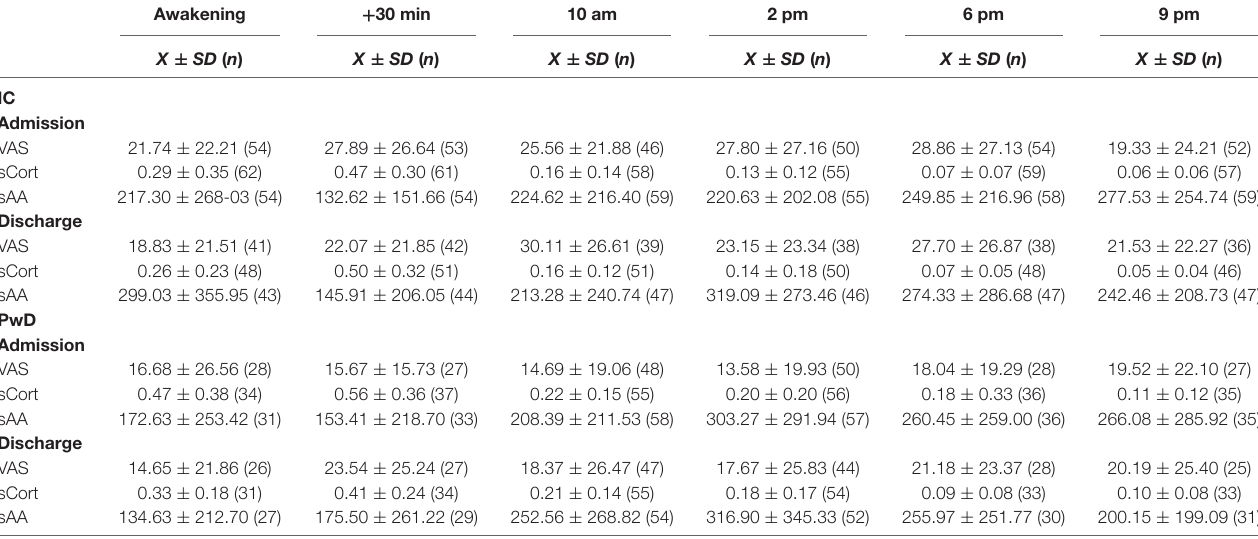
TABLE 3 | Ambulatory assessment